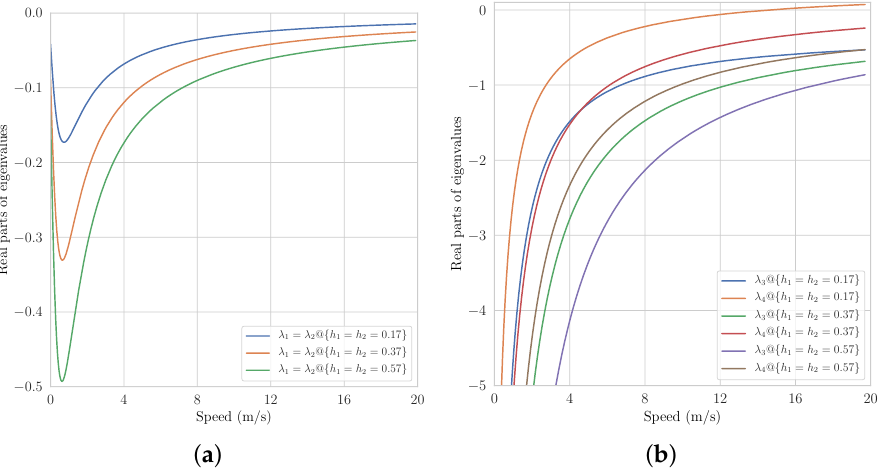
Figure 11. Variation of the real parts of the eigenvalues with the hydraulic cylinder force arm: ( a ) real parts of λ 1 and λ 2 and ( b ) real parts of λ 3 and λ 4